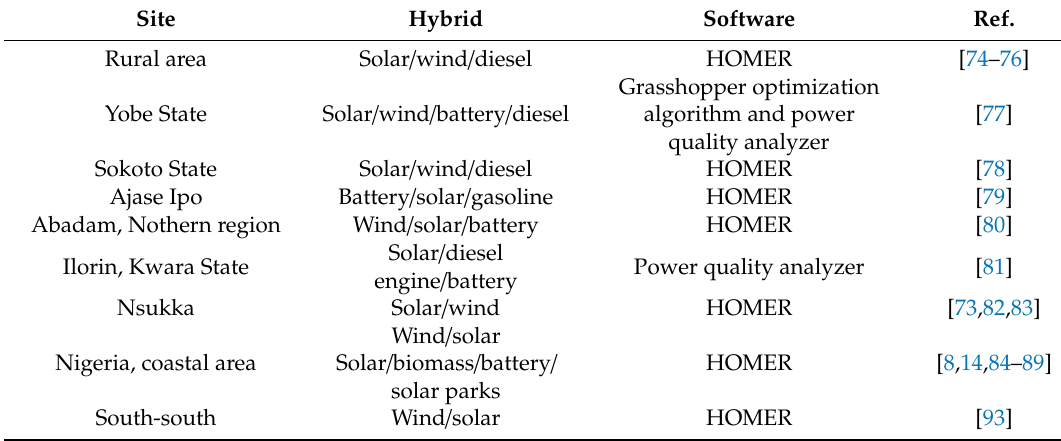
Table 3. Summary of literatures on hybrid